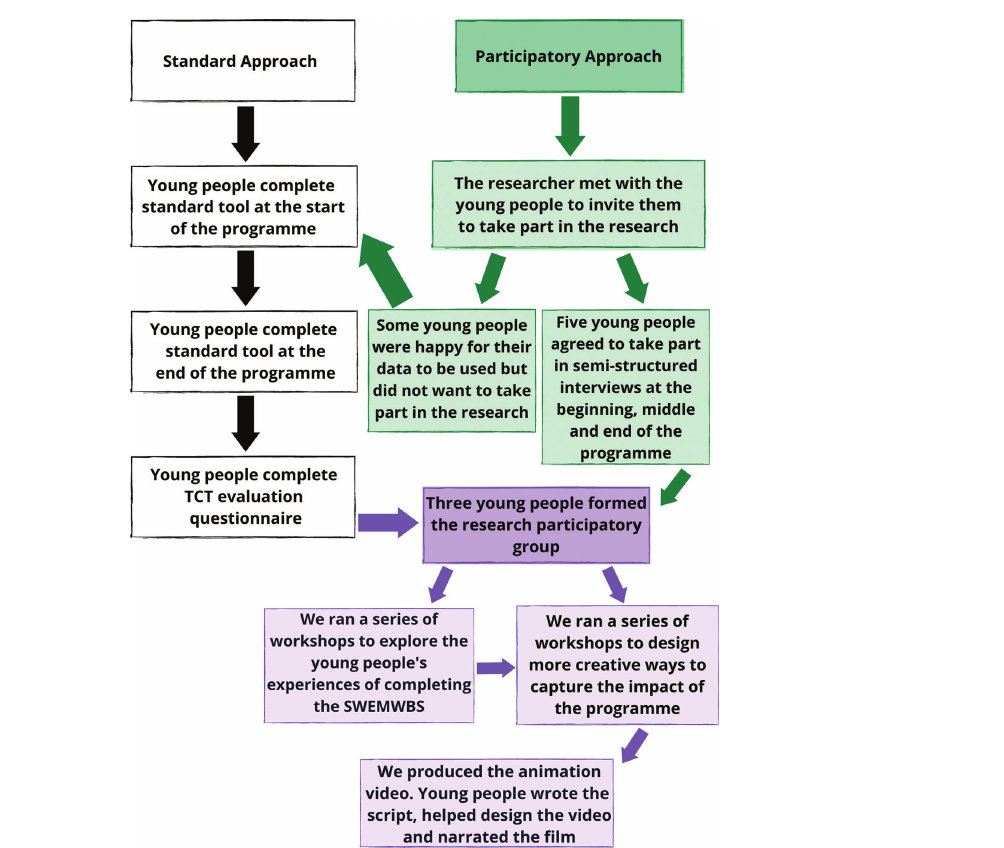
Figure 1. Overview of research process (Source: Authors,